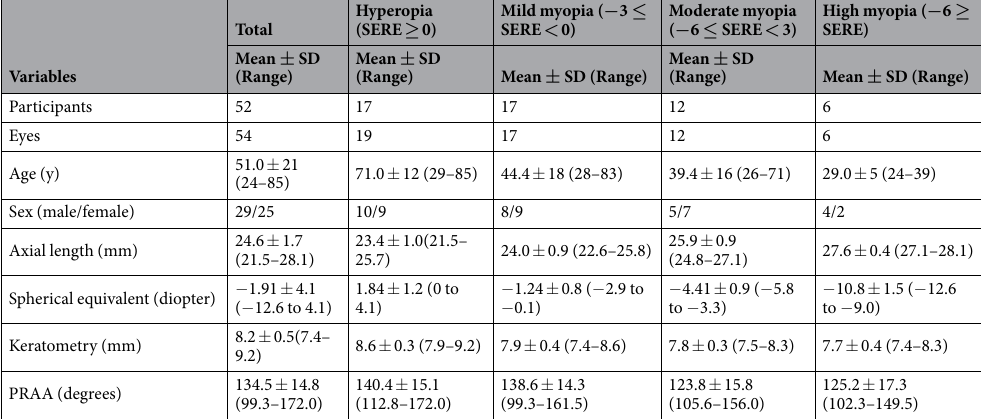
Table 1. Characteristics. SERE: spherical equivalent refractive error; SD: standard deviation; PRAA: peripapillary retinal arteries